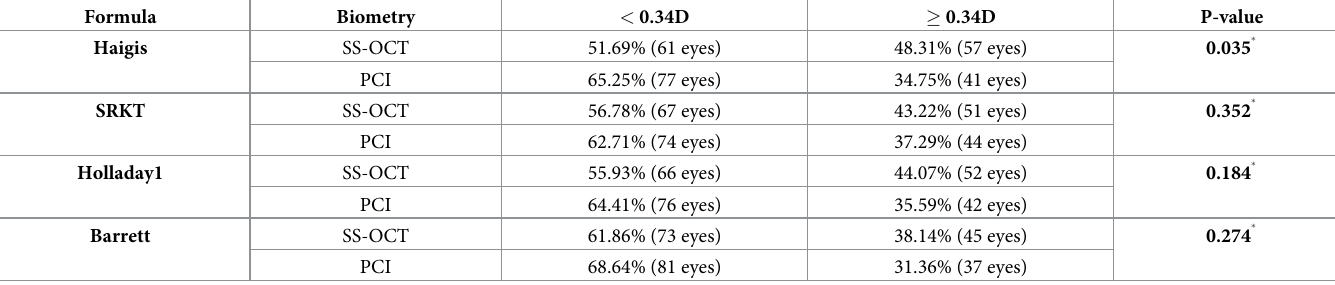
Table 4. Comparison of percentage divided by manifest refraction 0.34 D which assumed the difference by one level of IOL.